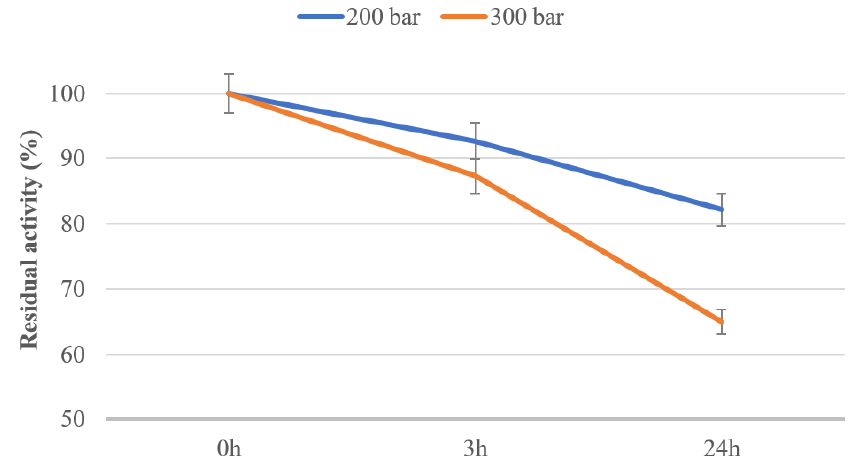
Figure 4. Residual activity of PPO in graham flour after exposure to scCO 2 at 200 bar and 300 bar after treatment times of 3 and 24 h.